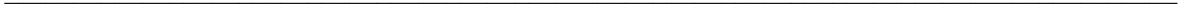
Fig. 5. A – F , Geragnostus cf. yangtzeensis Lu, 1975, Lower Ordovician, Tremadocian; A, NMW2012.45G.182, internal mould of cephalon, sample MK-5/12; B, NMW2012.45G.307, internal mould of cephalon, sample MK-5/11; C, NMW2012.45G.308, internal mould of cephalon, sample MK-5/11; D, NMW2012.45G.311.1, internal mould of cephalon, sample MK-5/11; E, NMW2012.45G.306.1, internal mould of pygidium, sample MK-5/11; F, NMW2012.45G.305.2, internal mould of pygidium, sample MK-5/11. G , Geragnostus sp., Lower Ordovician, Tremadocian; NMW2012.45G.309, internal mould of pygidium, sample MK-5/12A. H – O , Q , Conophrys gaoluoensis (Zhou in Zhou et al., 1977), Lower Ordovician, Tremadocian; H, NMW2012.45G.314, internal mould of cranidium, sample MK-5/11; I, NMW2012.45G.304, internal mould of cranidium, sample MK-5/11; J, NMW2012.45G.313, internal mould of cranidium, sample MK-5/12; K, NMW2012.45G.311.4, internal mould of cranidium, sample MK-5/11; L, NMW2012.45G.321.1, latex cast of cranidium, sample MK-5/11; M, NMW2012.45G.317.1, internal mould of pygidium, sample MK-5/11; N, NMW2012.45G.175.1, internal mould of pygidium, sample MK-5/11; O, NMW2012.45G.303.7, internal mould of pygidium, sample MK-5/11; Q, NMW2012.45G.312.1, 312.2, internal mould and external mould of cranidia, sample MK-5/11. P , bedding surface with several specimens of Conophrys gaoluoensis (Zhou in Zhou et al., 1977), NMW2012.45G.311.3–11; internal mould of cephalon of Geragnostus cf. yangtzeensis Lu, 1975, NMW2012.45G.311.1; and internal mould of cranidium of Dactylocephalus levificatus sp. nov., NMW2012.45G.311.2, sample MK-5/11. All scale bars are 1